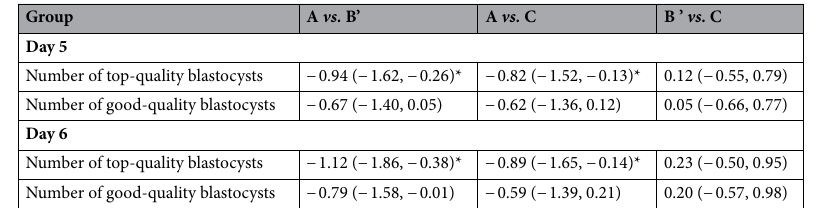
Table 4. Adjusted mean differences and 95% CI from linear model with adjustment for multiple comparisons between groups A, B’ and C. * P < 0.05.